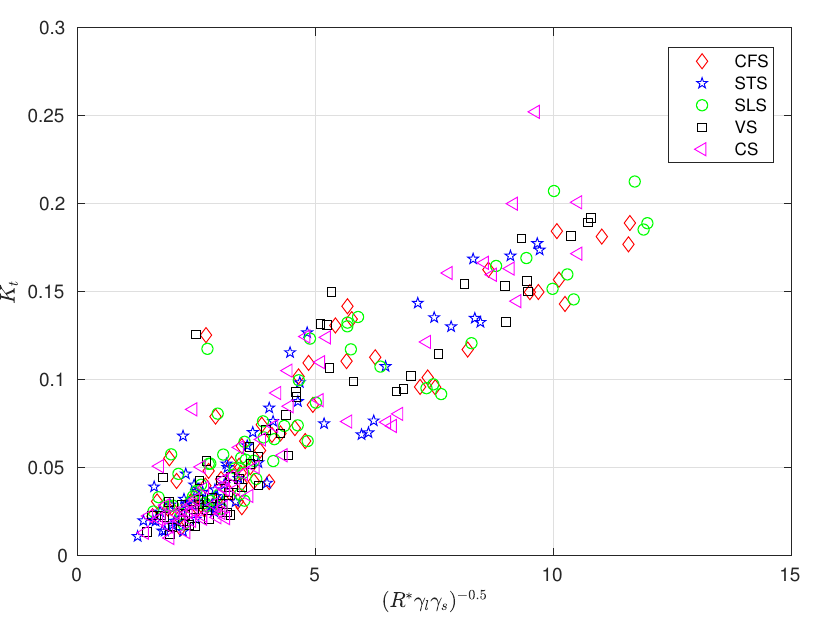
Figure 6. Transmission coefficient vs. R ∗ . The symbols denote the seawall